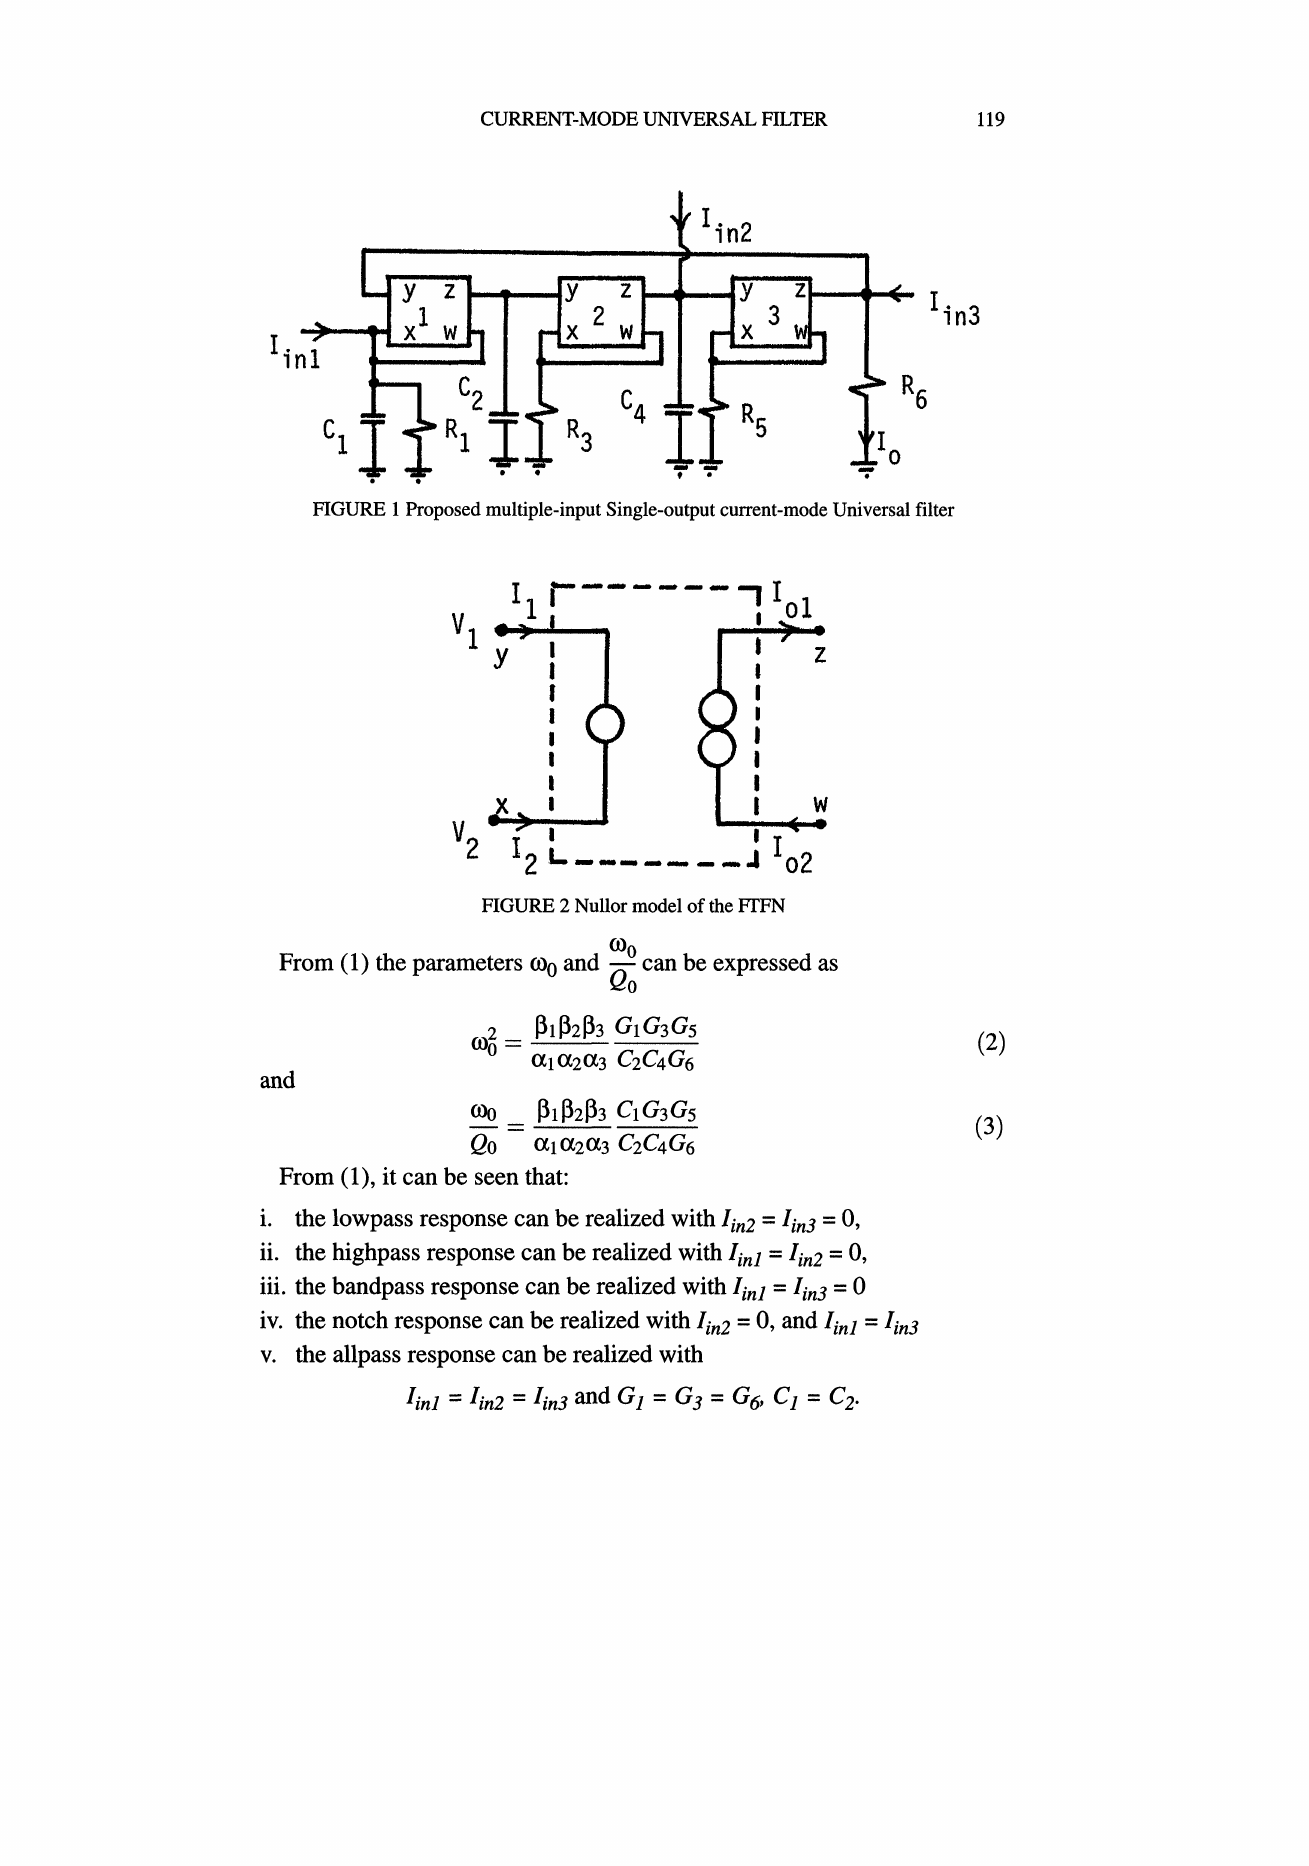
FIGURE Proposed multiple-input Single-output current-mode Universal filter